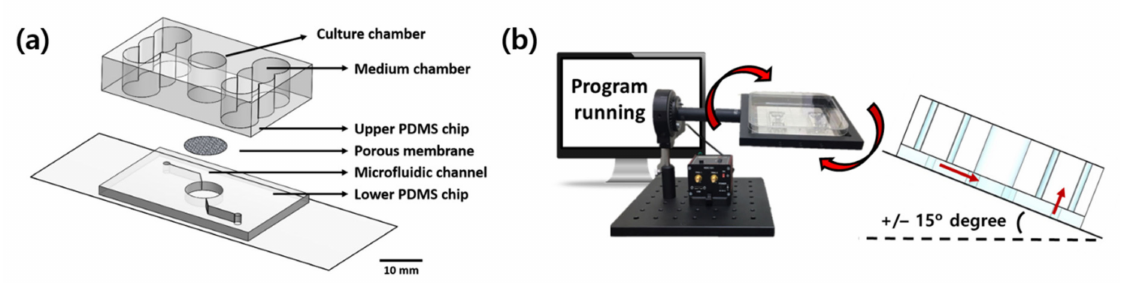
Figure 7. Schematic diagram of the pumpless microfluidic chip and gravity flow system in action. ( a ) Configuration diagram of pumpless microfluidic chip. ( b ) Schematic diagram of the operation of the gravity flow system. Both sides are shaken at a 15 ◦ slope to allow the medium to circulate through the microfluidic